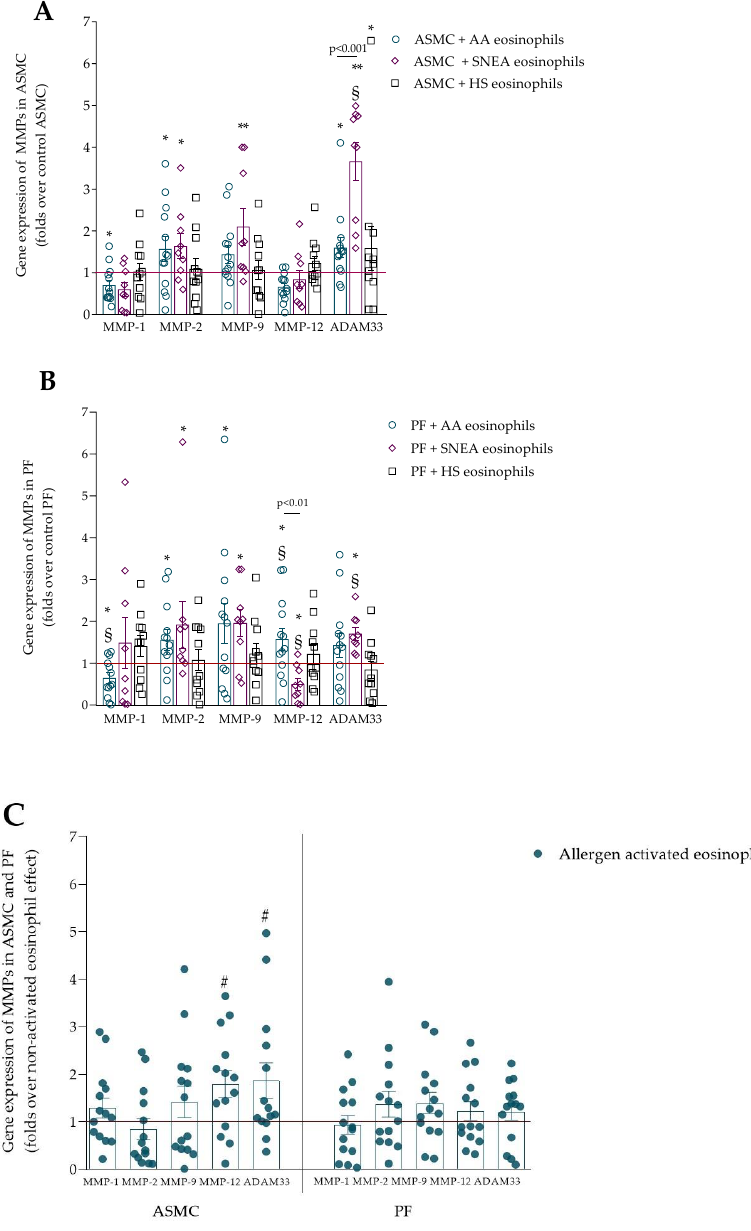
effect on LTBP2 and LTBP3 gene expression in PF, compared with HS eosinophils. TGF- β 3 gene expression was absent in all experiments.